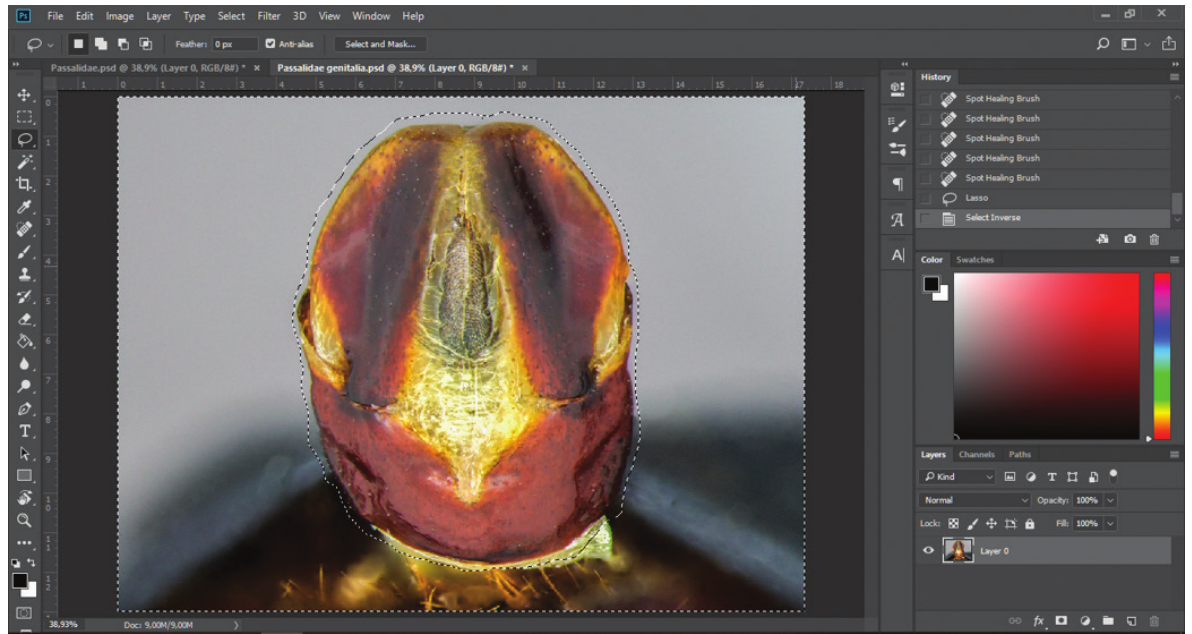
Figure 14. Selected area with the Lasso tool being inverted to be deleted.